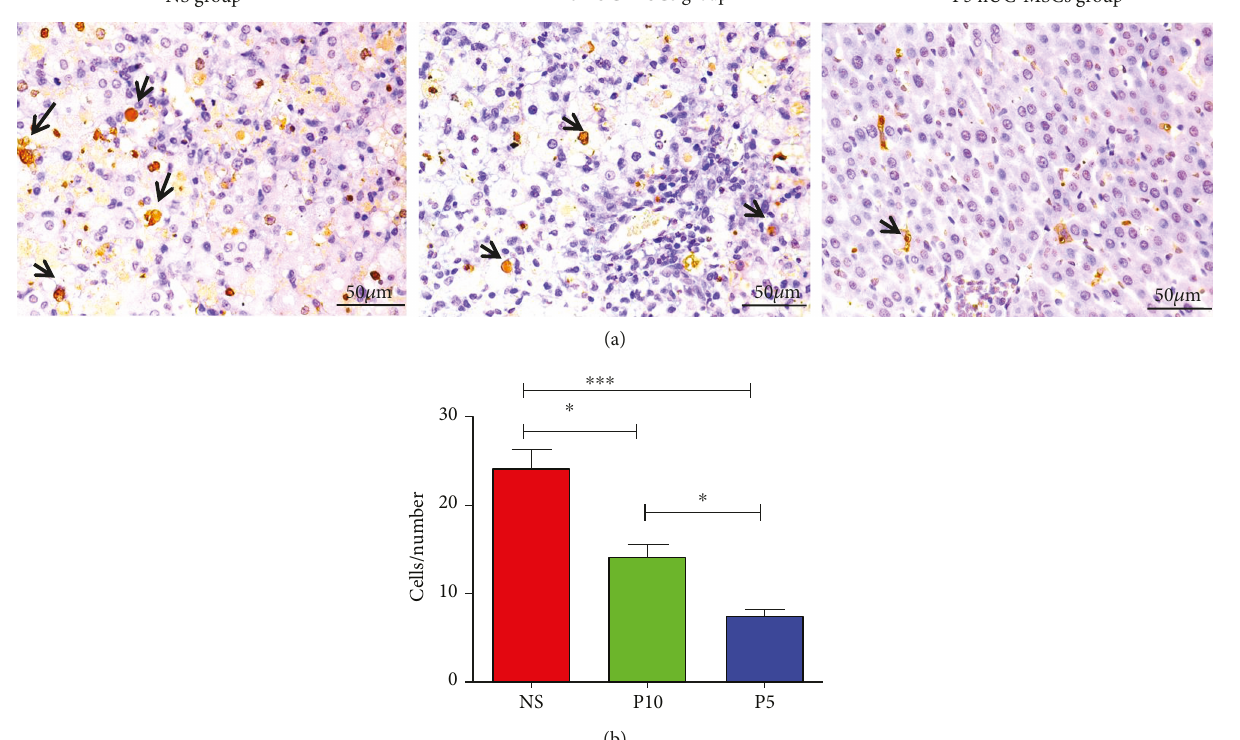
Figure 4: Infusion of hUC-MSCs decreases levels of apoptosis in livers D-GaIN/LPS-induced ALF. (a) Liver sections were stained by TUNEL (dark brown nuclei). Representative images from NS-treated, P10 hUC-MSC-treated, and P5 hUC-MSC-treated rats. Bar=50 μ m. (b) Quanti fi cation of TUNEL-positive hepatocyte-nuclei by digital image analysis. Data are reported as mean ± SD. ∗ P < 0 05 , ∗∗∗ P < 0 001 . TUNEL, terminal deoxynucleotidyl transferase-mediated nick-end